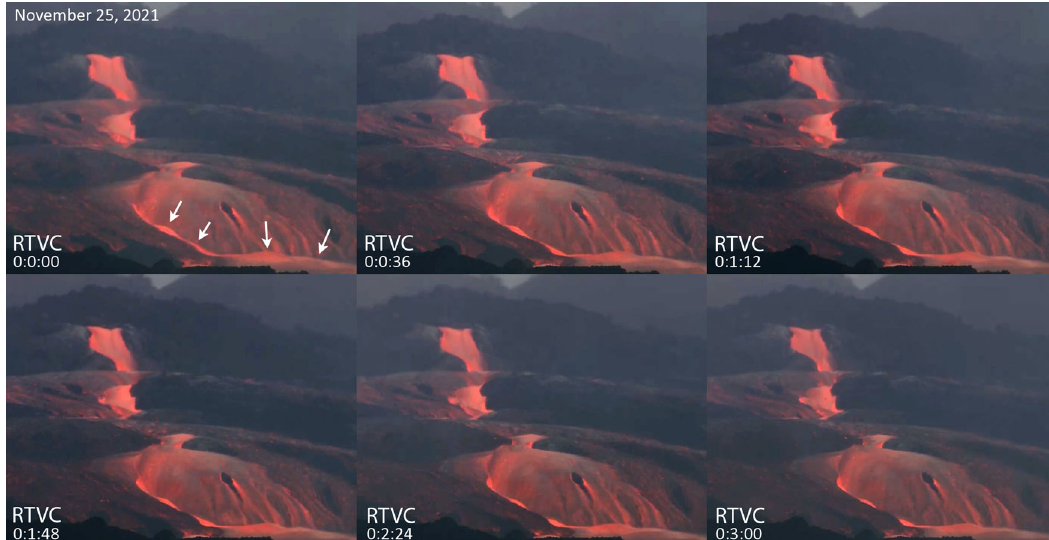
Fig. 3 Supercritical fl ow phenomena in near-vent lavas, Cumbre Vieja. Montage of image frames collected from open-source eruption video feed (RTVC/ TV-Canarias) indicating the existence of standing waves (white arrows) in lavas of the near-vent region on 25 November 2021, at approximately 9:26 a.m. local time. The exact location and scale of these waves are unknown. The time markers show relative time for a three-minute interval of the sampled video. The presence of standing waves qualitatively indicates that this fl ow was in a supercritical state, involving high Froude numbers 20 . White arrows indicate the positions of a wave train that remained in place for a total of 8 min. After this period, the waning of the mass discharge rate at the vent, and crust formation ultimately lead to the disappearance of these standing sampling sites, embedded in epoxy, and polished for electron probe microanalysis and imaging by back-scattered electron methods. These grain separates derive from the same bulk samples used for both XRF analyses and rheometry experiments.